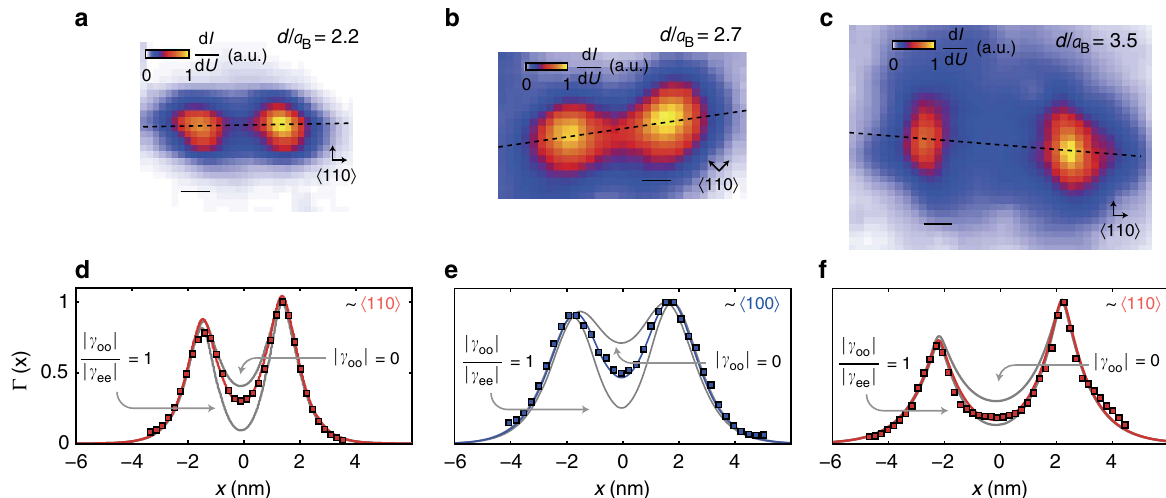
Figure 3 | Resolving interference processes in quasi-particle wave function. ( a ) Experimentally measured, normalized tunnelling probability G p d I /d U to tip, for d ¼ 2.2 a B ground state. Arrows denote 110 crystal directions. ( b ) Same as ( a ), for d ¼ 2.7 a B . ( c ) Same as ( a ) for d ¼ 3.5 a B . ( d ) Normalized experimental line profile (coloured squares) of G ( x ) for d ¼ 2.2 a B and least-squares fit (coloured line) to QPWF correlated singlet model. Lower and upper grey lines are line profiles of maximally and minimally correlated states, obtained from least square fits. The maximally correlated state deviates from the mean of | f e ( r )| 2 and | f o ( r )| 2 because of the different normalization coefficients of even and odd linear combinations. ( e ) Same as ( d ) for d ¼ 2.7 a B . ( f ). Same as ( d ) for d ¼ 3.5 a B . Scale: 1nm.